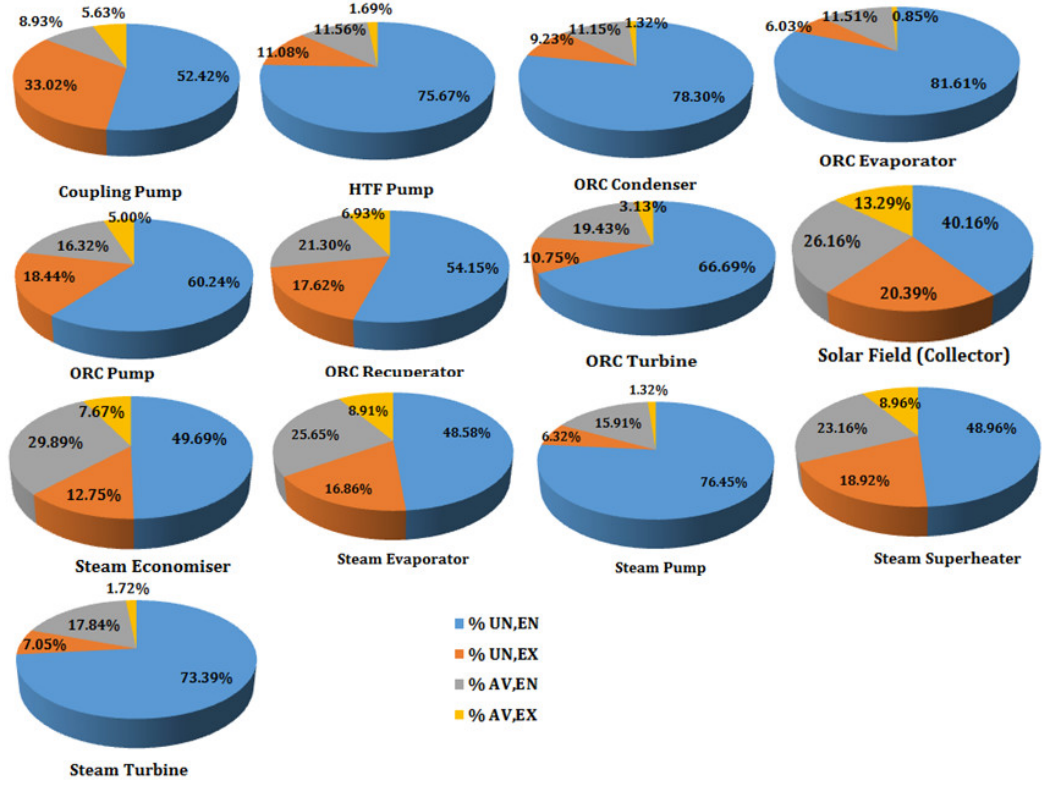
Figure 8. Advanced exergo-environmental destruction rate of each component in the solar–geothermal cycle (SGPP).